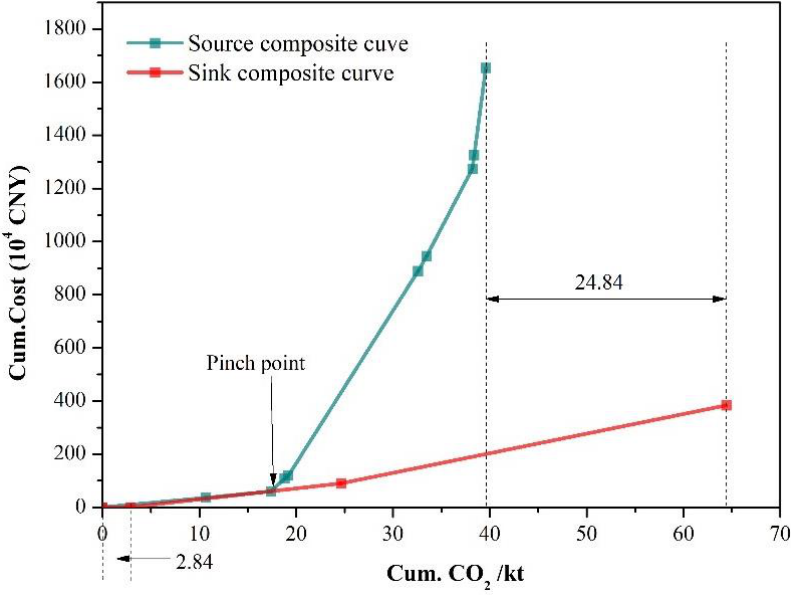
Figure 8. Optimized source – sink model of the tobacco industry for Scenario 3.